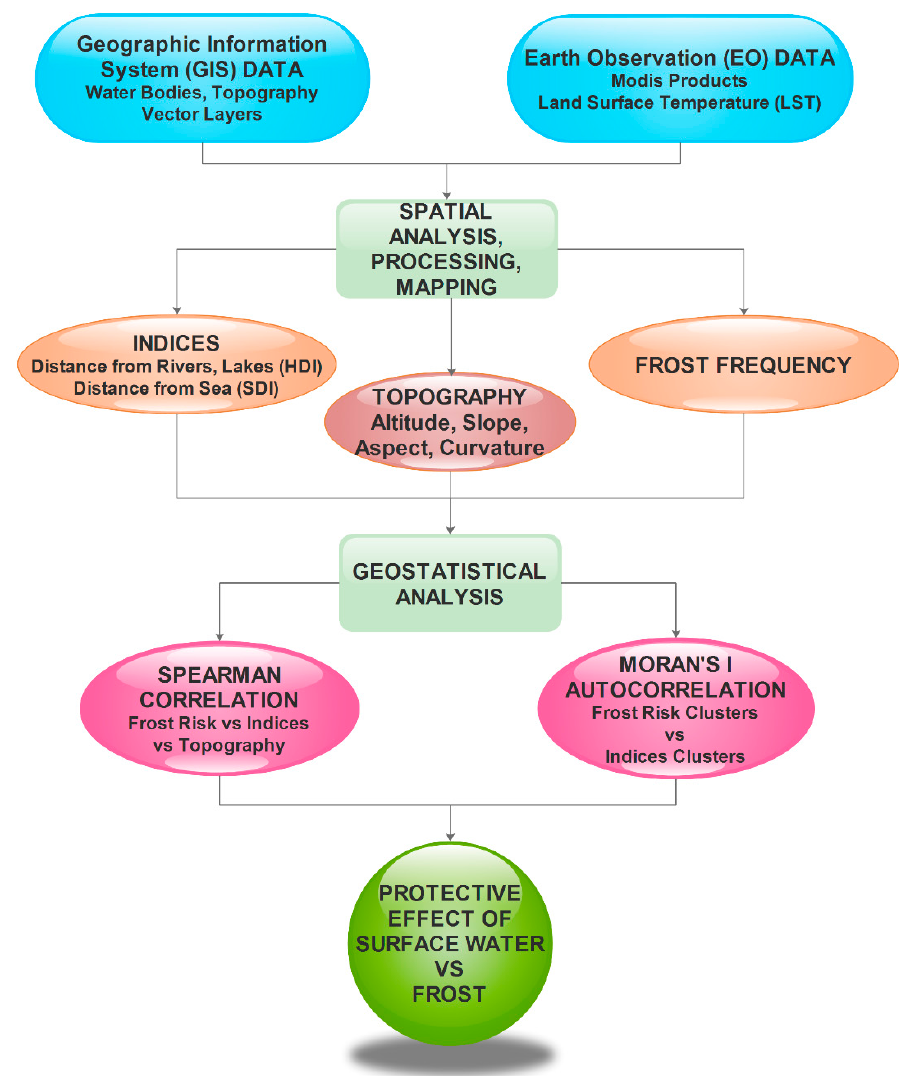
Figure 2. Flowchart of the methodology.